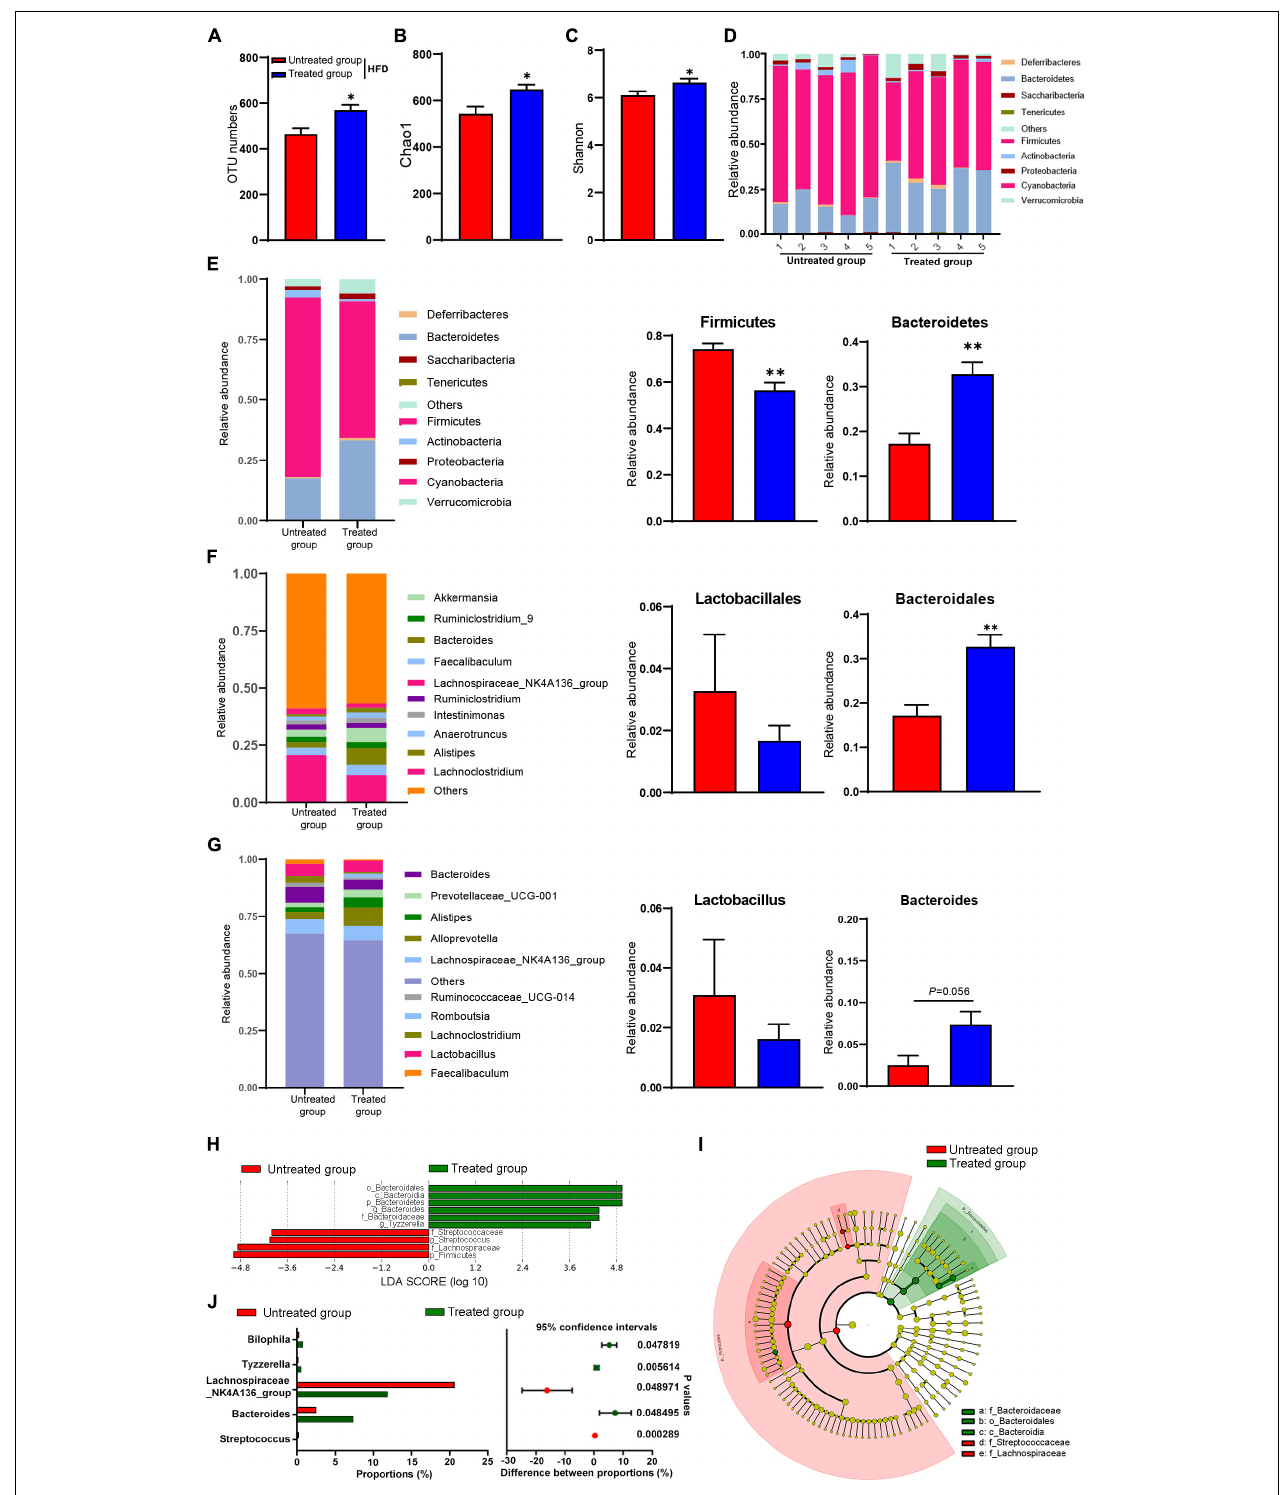
FIGURE 3 | Gut microbiota in response to fecal microbiota transfer ( n = 5). (A) OTU numbers analysis. (B) Chao1 index in a-diversity analysis. (C) Shannon index in a-diversity analysis. (D,E) Microbiota compositions at the phylum level. (F) Microbiota compositions at the order level. (G) Microbiota compositions at the genus level. (H) Biomarker taxons generated from LEfSe analysis. (I) Cladogram obtained from LEfSe analysis with presenting various levels (phylum, class, order, family, genus) from inner to outer rings. (J) Taxon composition with the top 5 typical bacteria on the genus level ( P < 0.05, determined by Wilcoxon rank-sum test). Data are presented as means ± SEM. Differences were assessed by ANOVA. ∗ P < 0.05, ∗∗ P < 0.01.